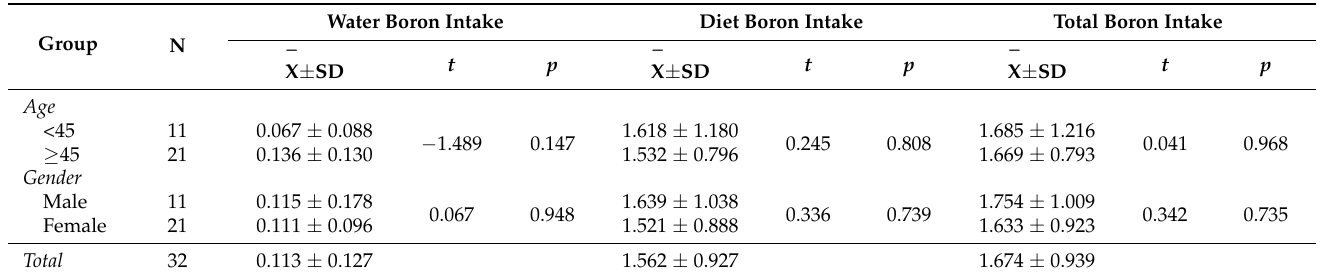
Table 3. Boron intake in different populations